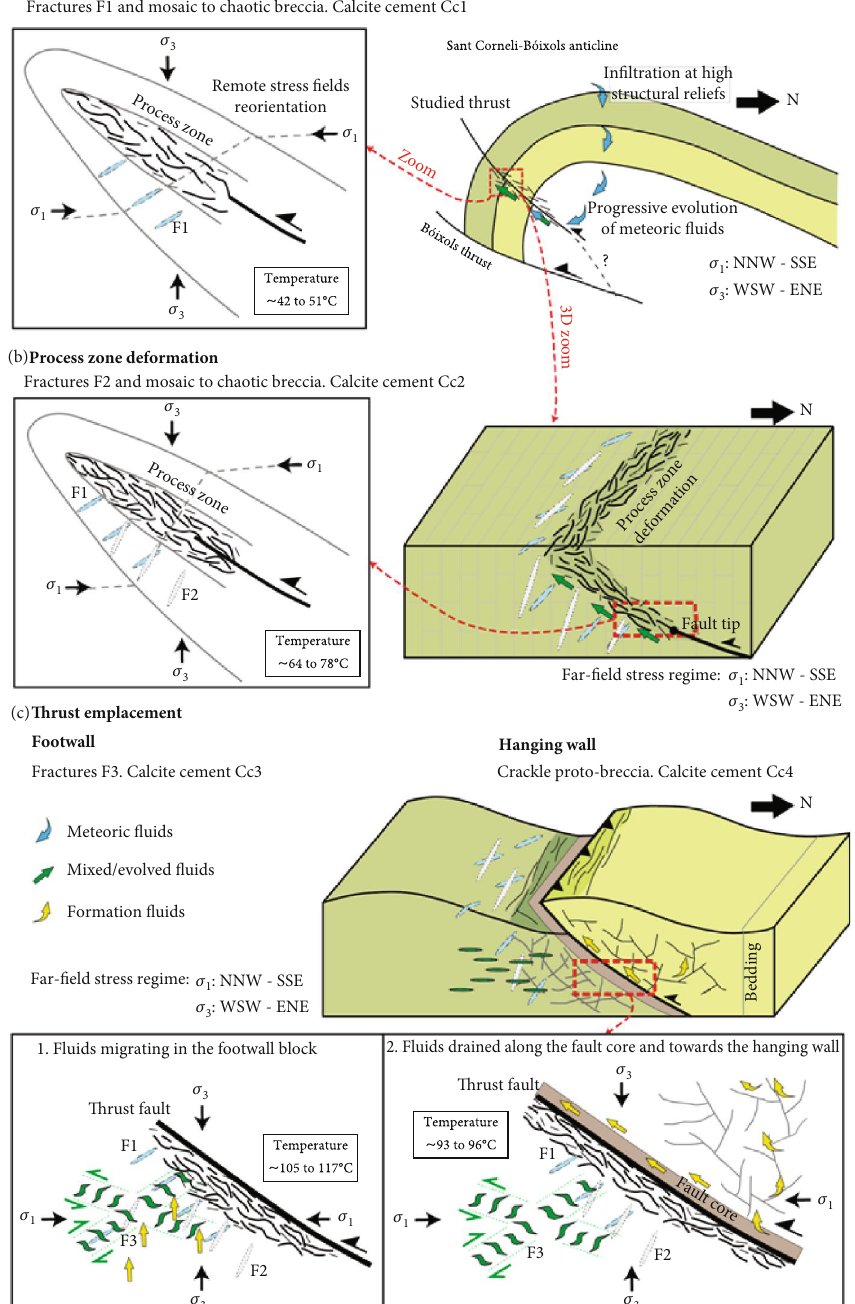
Figure 13: Fluid fl ow model during the evolution of the studied thrust (not to scale) showing the relationships between synkinematic fracture development, the stress state at each deformation phase, and the involved fl uid fl ow event. (a) During initial fault growth, deformation was concentrated in the process zone (around the fault tip) allowing the formation of fractures F1 and randomly oriented fractures (mosaic to chaotic breccia). During this episode, meteoric fl uids in fi ltrated at high structural reliefs, warmed at depth, and then migrated through di ff used deformation around the fault tip. (b) During progressive deformation, new fractures develop and meteoric fl uids evolved at increasing depths and temperatures. During these two initial fracturing events (F1-F2), the remote stress fi eld varied locally within the process zone to generate steeply dipping fractures. (c) As the thrust developed, fractures F3 were formed in the footwall damage zone. The orientation of these fractures re fl ects the far- fi eld stress regime unaltered by faulting. The fl uid involved in this stage evidences the continuous increase in precipitation temperatures due to burial during thrust emplacement. From this stage, the thrust drained fl uids that only in fi ltrated in the hanging wall. These fl uids were likely expelled from underlying Cretaceous carbonates due to rock compaction during